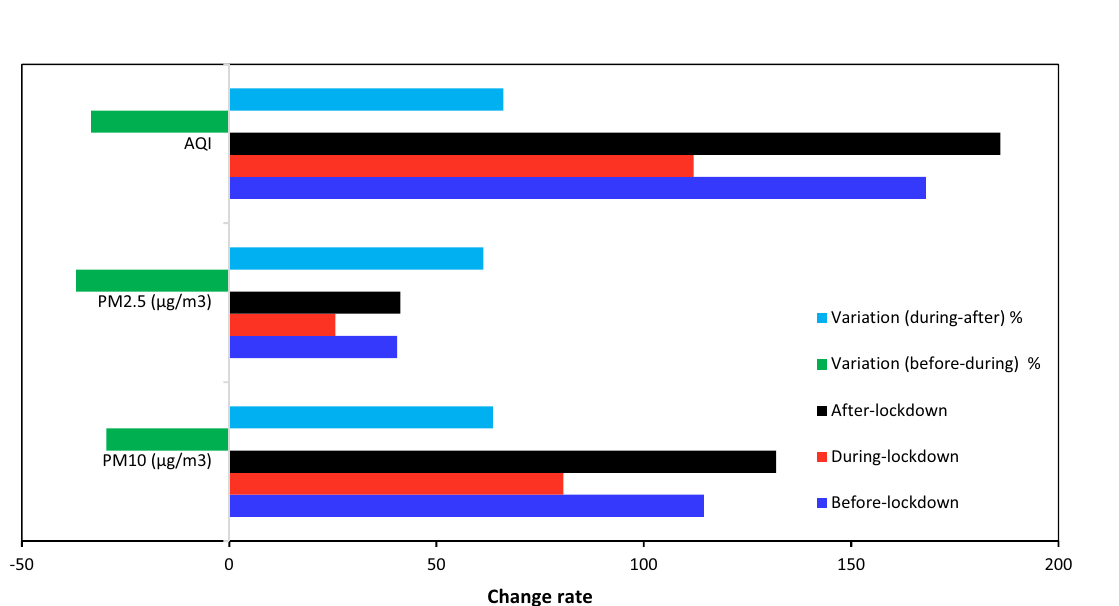
The strongest correlations are shown in bold ( ns not significant, P >